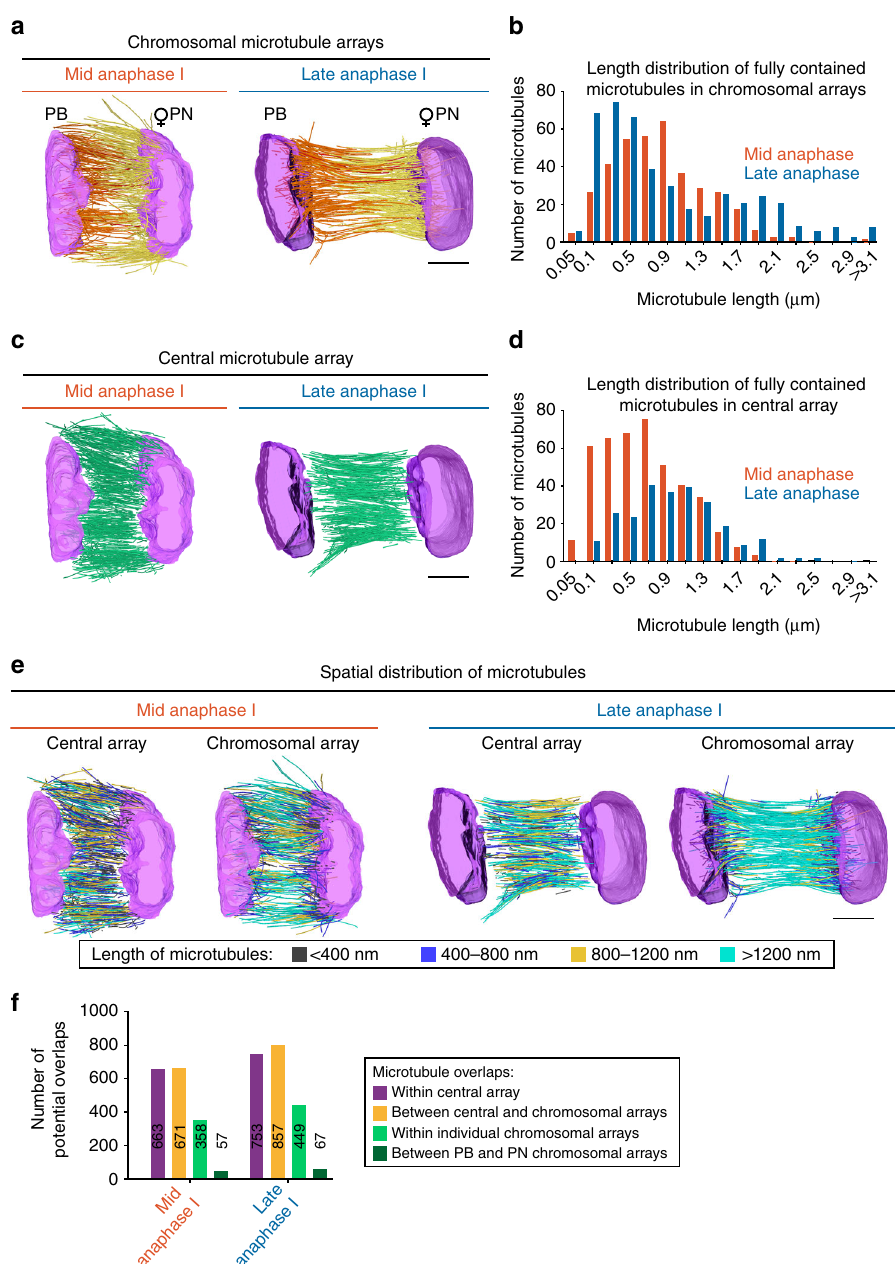
Fig. 3 The meiotic central spindle is comprised of two interconnected arrays of microtubules. a Partial spindle reconstructions for mid- (left) and late (right) anaphase I chromosomal microtubule arrays. Model of chromosomes (magenta) and either polar body (PB) proximal microtubules (orange), future maternal pronucleus (PN) proximal microtubules (yellow), or microtubules which contact both chromosome masses (red). b Length distribution of fully contained microtubules in the chromosomal microtubule arrays for mid- (orange) and late (blue) anaphase I spindle reconstructions. c Partial spindle reconstructions for mid- (left) and late (right) anaphase I central microtubule arrays. Model of chromosomes (magenta) and microtubules (green). d Length distribution of fully contained microtubules in the central array for mid- (orange) and late (blue) anaphase I spindle reconstructions. e Microtubule length distribution within partial spindle reconstructions for mid-anaphase I central (far left) and chromosomal (left) microtubule arrays, and late anaphase I central (right) and chromosomal (far right) microtubule arrays. Microtubules are color-coded according to their length as indicated. Scale bars, 1 µ m. f Quanti fi cation of microtubule overlaps > 200 nm in length for the indicated